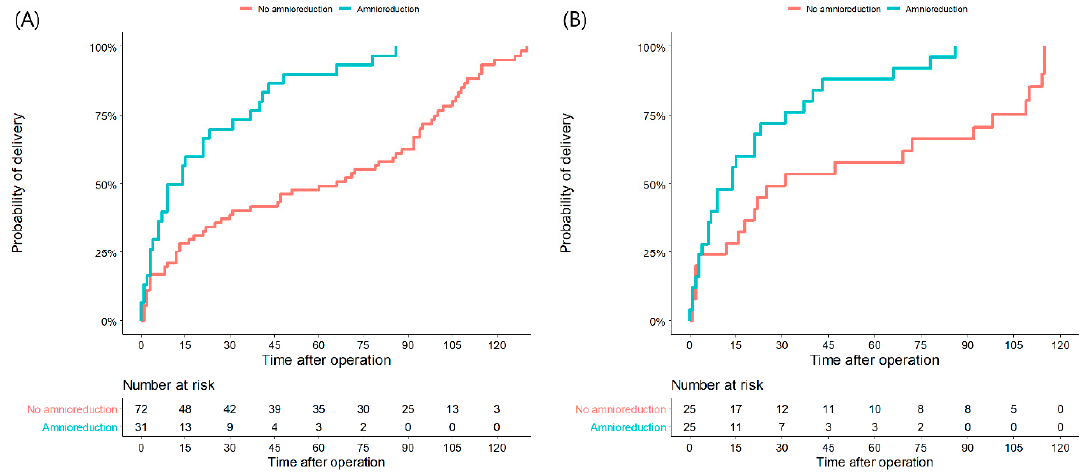
Figure 1. Kaplan–Meier curves for time to delivery in unmatched( A ) and matched patients ( B ) who underwent amnioreduction or did not. Survival curves show the di ff erences in delivery proportions according to the latency period (days from operation to delivery) between two